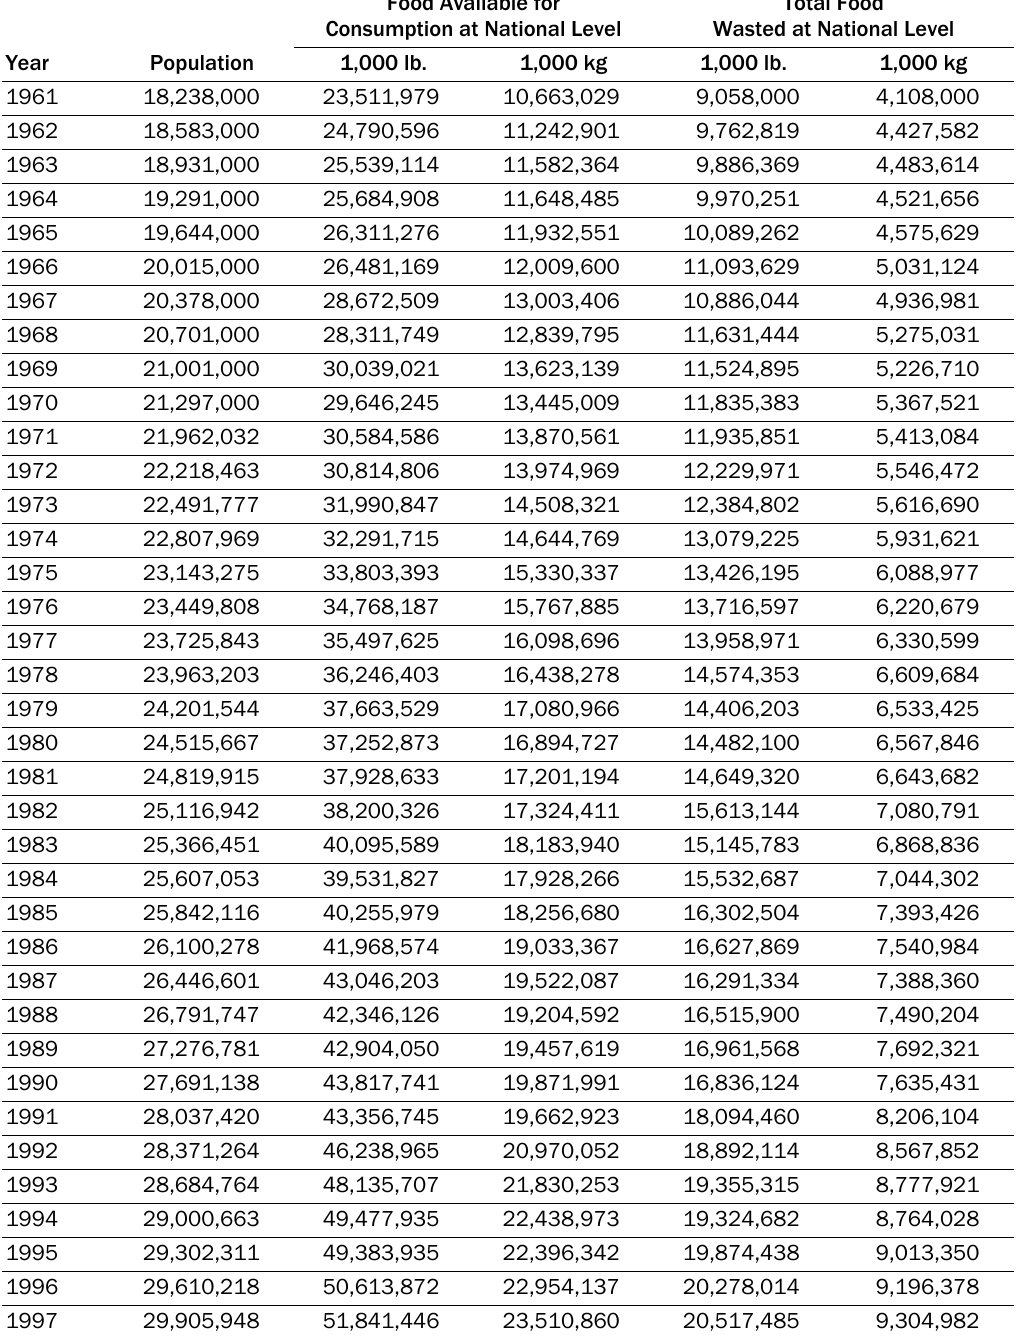
Table 2. Population, Total Food Available and Food Wasted at National Level,